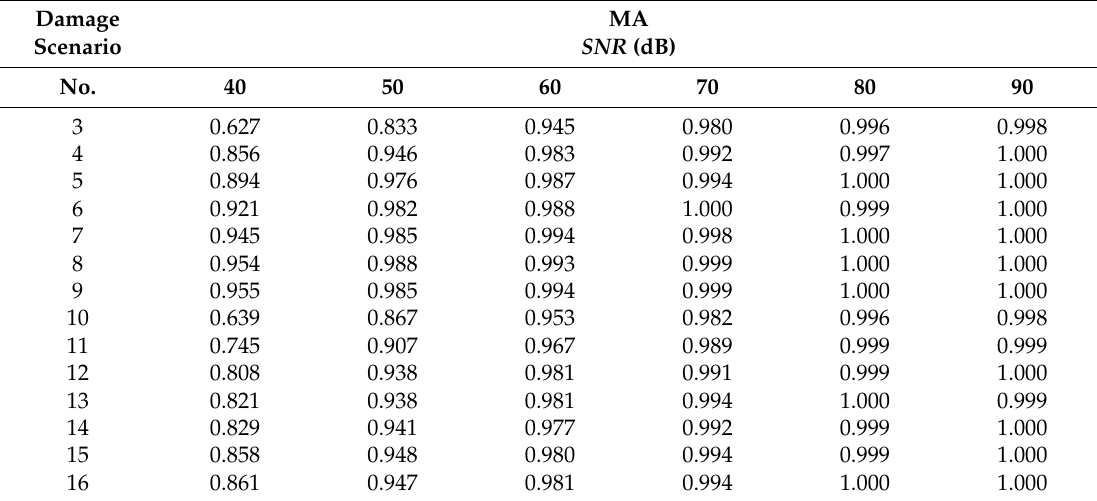
Table 3. MA values from Monte Carlo simulations for different noise